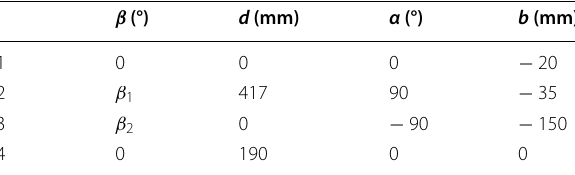
Table 1 Parameters of DH model of two series